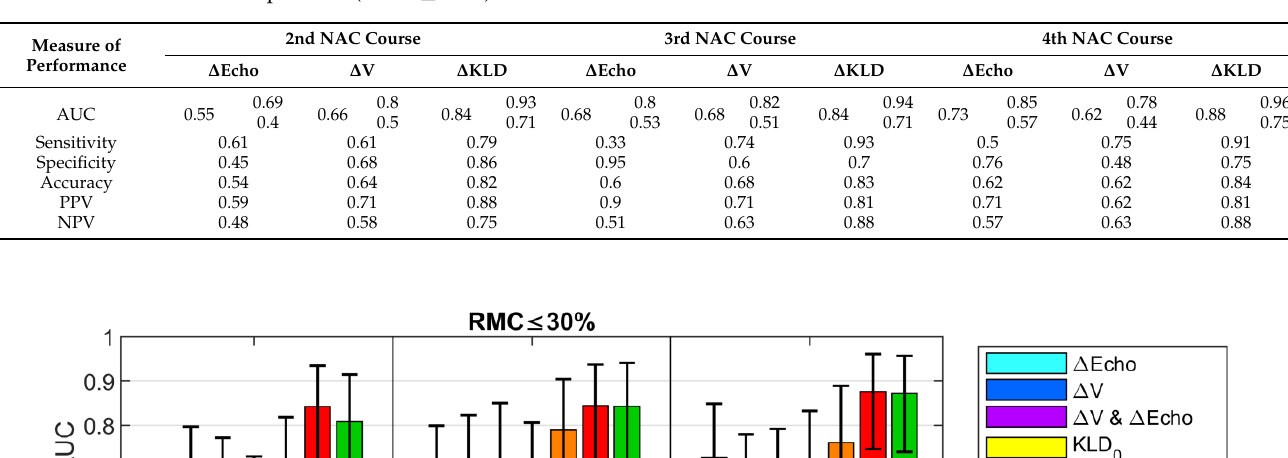
Table 4. Results of statistical analysis for changes in echogenicity, volume, and ∆ KLD parameter after two, three and four courses of NAC for responders (RMC ≤ 30%).